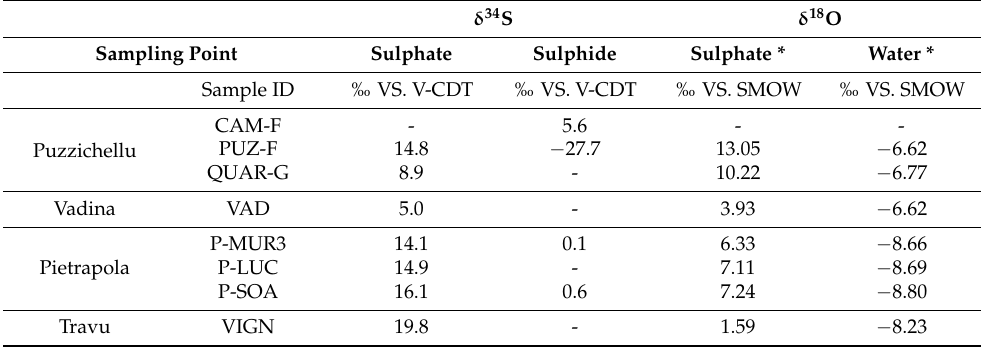
Figure 9. Sulphur isotopes data displayed as: ( A ) Origin of sulphate components thanks to δ 18 O(SO 4 ) versus δ 34 S(SO 4 ) content in mineral waters according to bibliography values associated to their SO 4 - content. ( B ) Abiotic or biotic sulphate origin determination thanks to δ 18 O(SO 4 ) versus δ 18 O(H 2 O) values observed. Dashed straight and solid lines delimit the area where dissolved sulphate (SO 42 − ) is obtained from inorganic redox processes, from sulphur (S − ) or sulphite (SO 32 − ) [76]. ( C ) Geother- mometers determination thanks to δ 18 O(SO 4 ) versus δ 18 O(H 2 O). Dark lines show temperature reservoir determination obtained for low enthalpy reservoir only [77]. The spring group of Pietrapola is displayed in red background while Puzzichellu is displayed in yellow background. Table 5. S isotopes values from sulphate (SO 4 ), sulphide (H 2 S) and 18 O-SO 4 , 18 O-H 2 S values. (*) Values used in isotope geothermometry